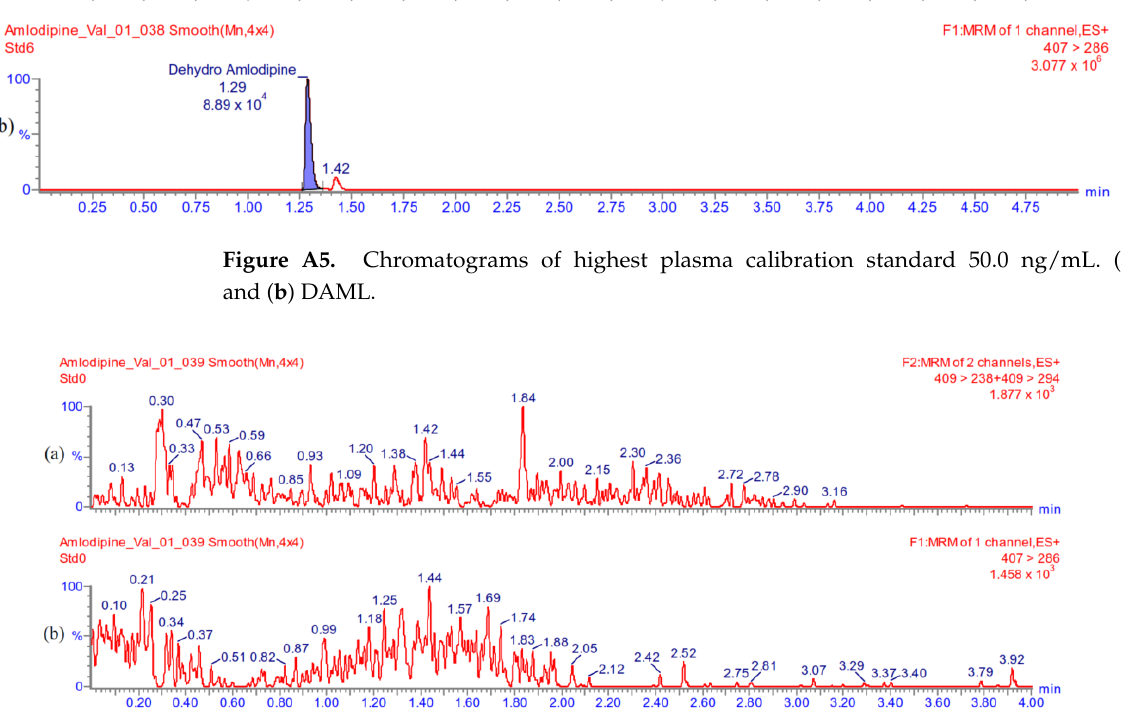
Figure A6. Chromatograms of back-calculated samples injected following the highest calibration standard analysis. ( a ) AML MRM channel and ( b ) DAML MRM channel.